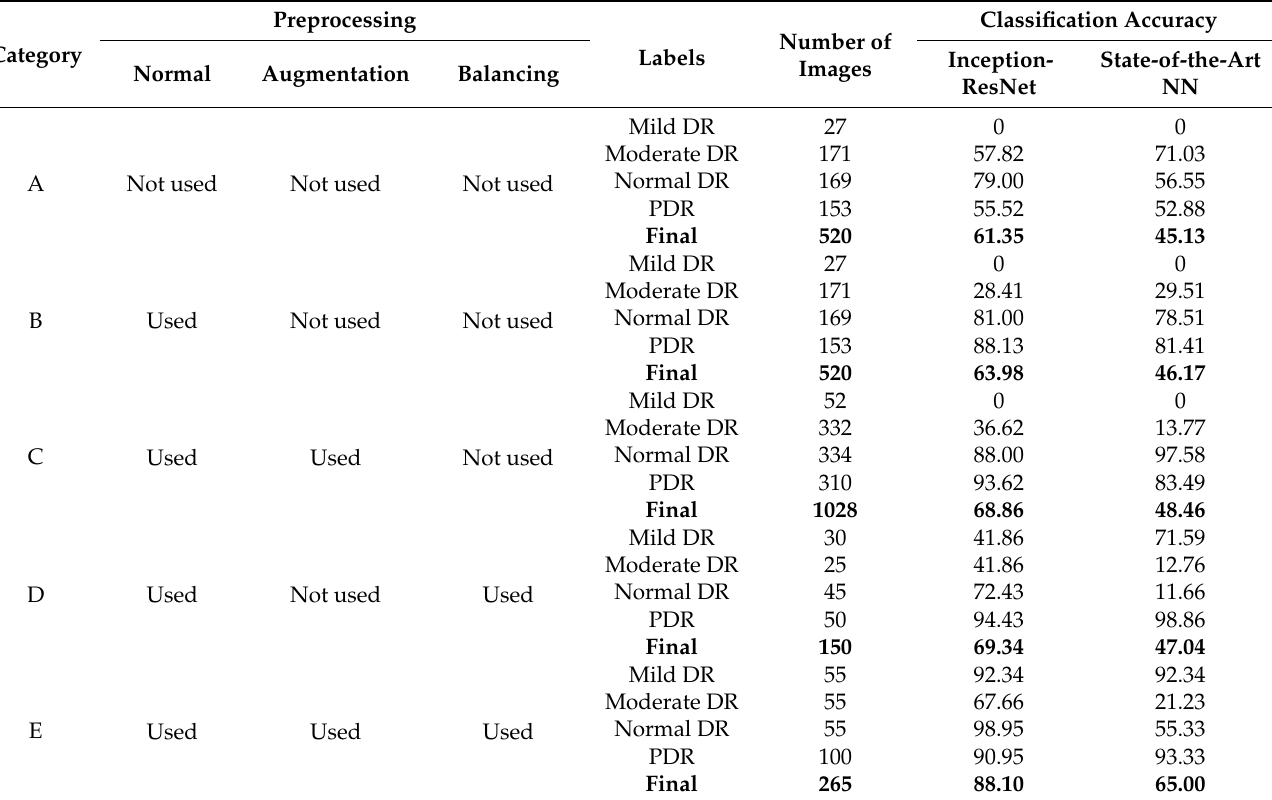
Table 2. Results comparison for the severity grading of the first phase of four levels of diabetic retinopathy with the help of alternate